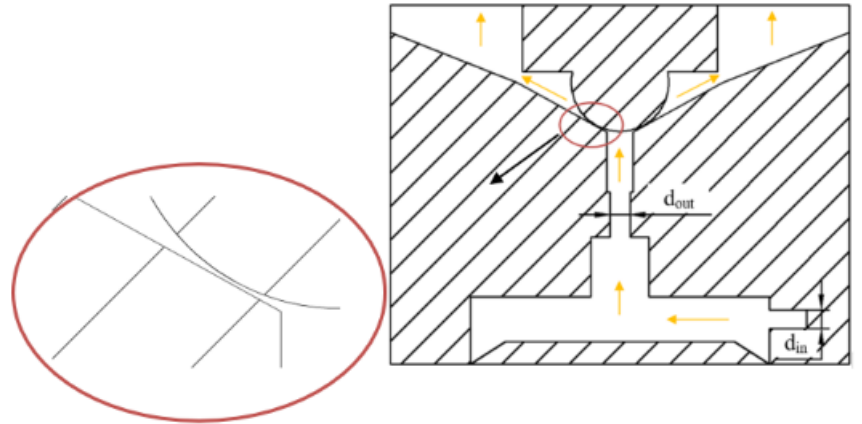
Figure 8. The schematic diagram of the control valve structure. Table 3. Simulative geometric dimensions of outlet throttle hole.